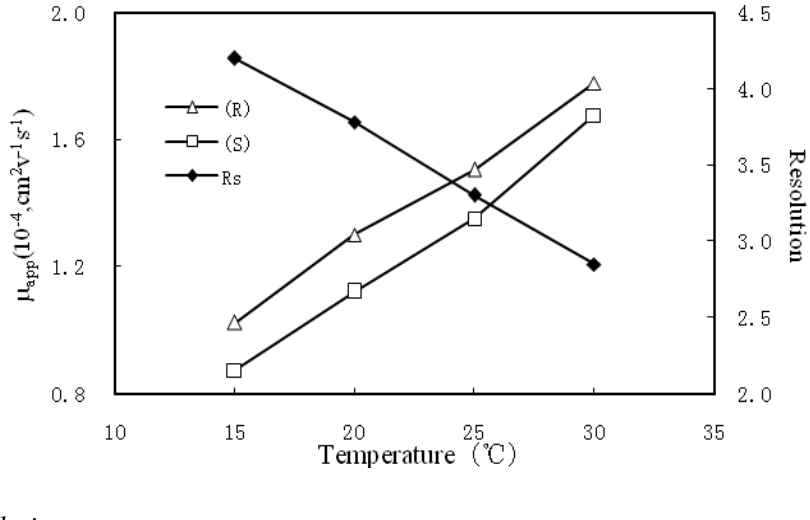
Figure 5. The effect of temperature on resolution. Separation condition: 20 mmol/L SBE - β -CD in 20 mmol/L phosphate buffer (pH 7.5) containing 20% methanol; the other 7 conditions are same as in Figure